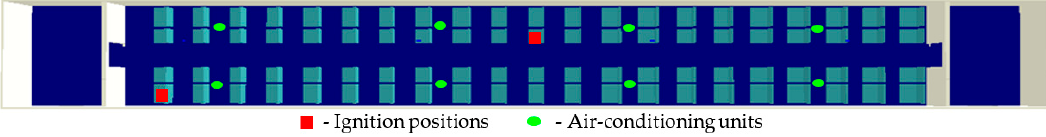
Figure 2. Ignition and air-conditioning within the railway carriage.